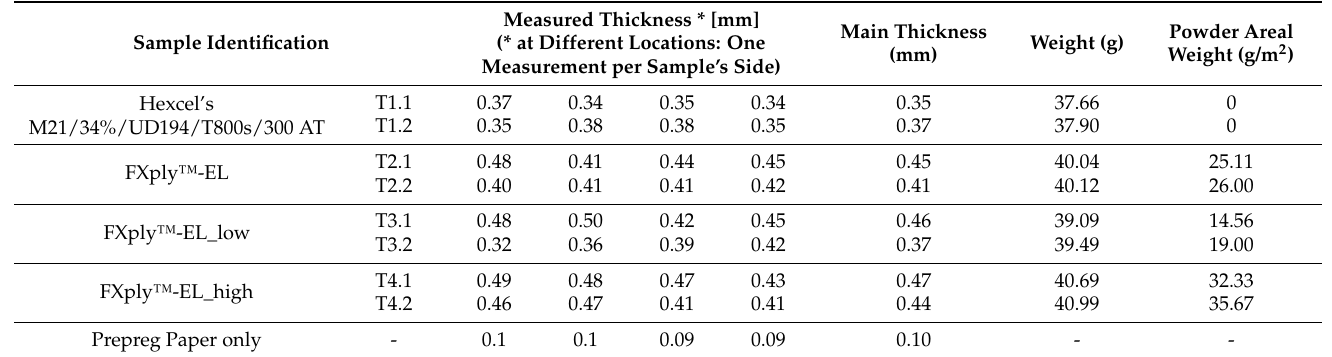
Table 4. Thin film prepreg parameters.